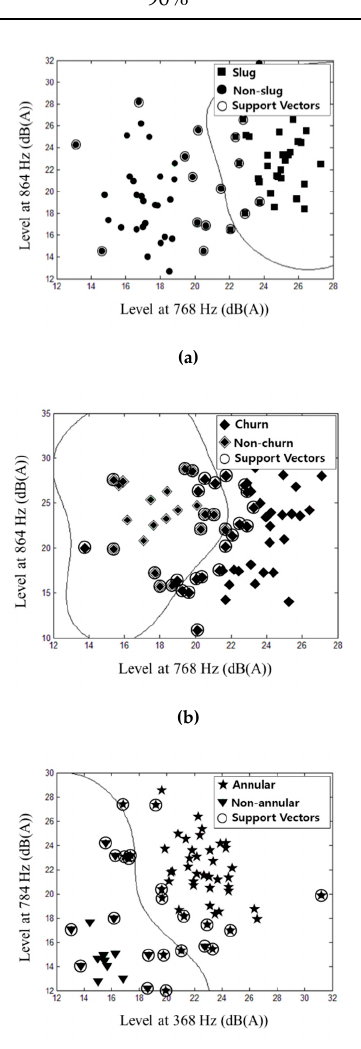
Figure 8. Kernel SVM classification for modified noises (2-D plot): ( a ) Slug flow, ( b ) Churn flow, ( c ) Annular